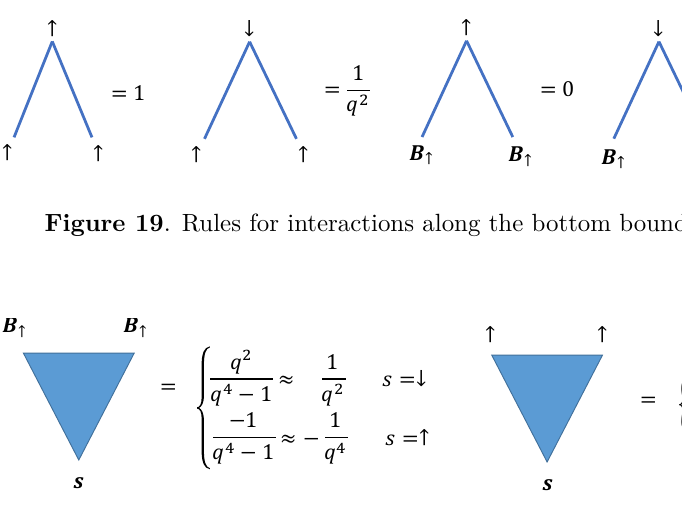
Figure 20 . Rules for interactions along the top boundary.